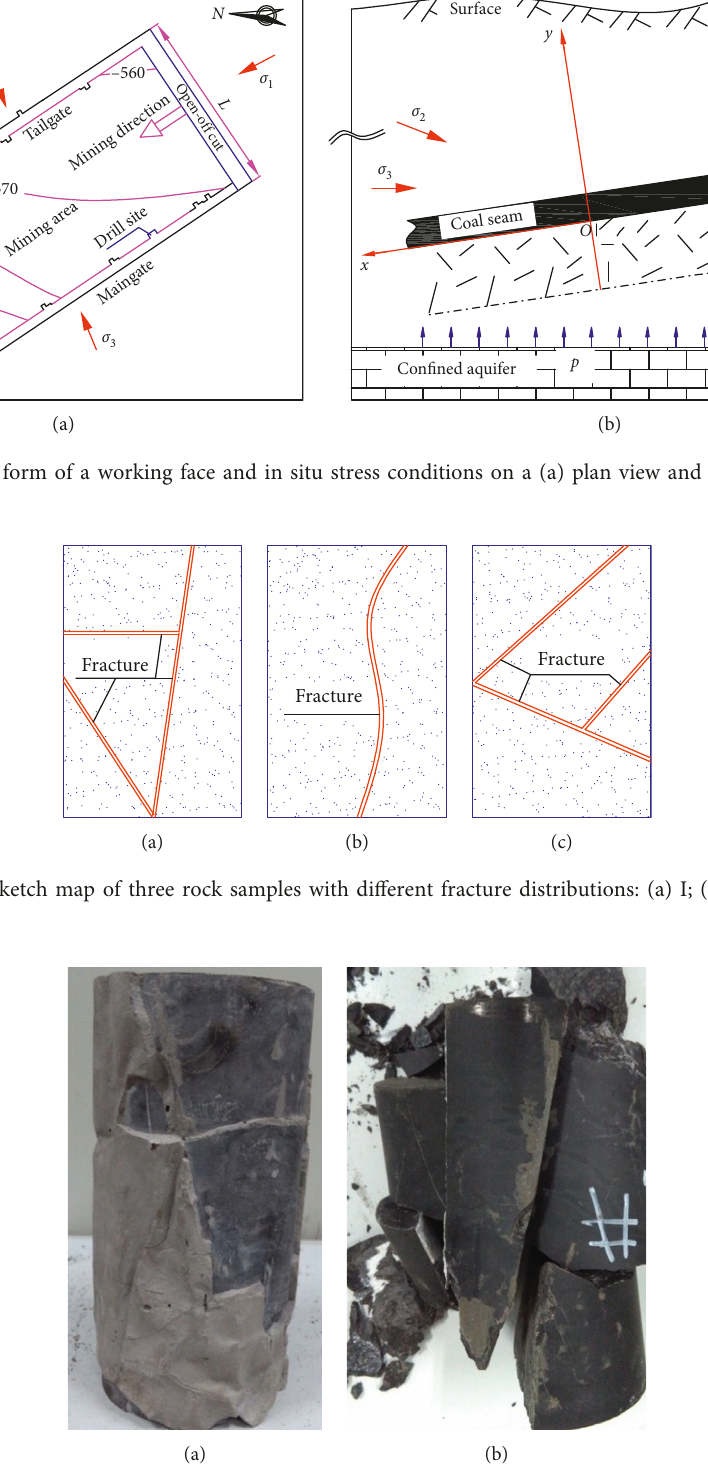
Figure 5: Photos of rock samples (a) after grouting and (b) before